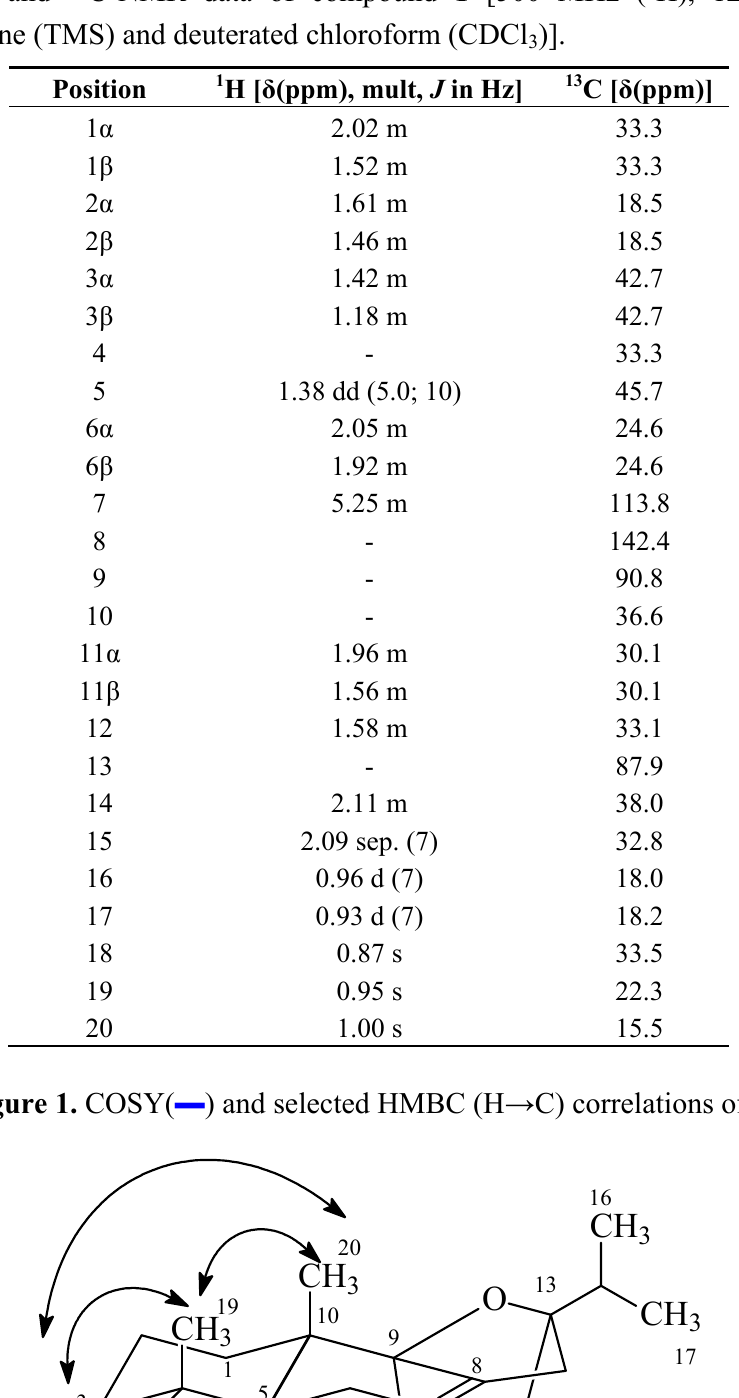
Table 1. 1 H- and 13 C-NMR data of compound 1 [500 MHz ( 1 H), 125 MHz ( 13 C), tetramethylsilane (TMS) and deuterated chloroform (CDCl